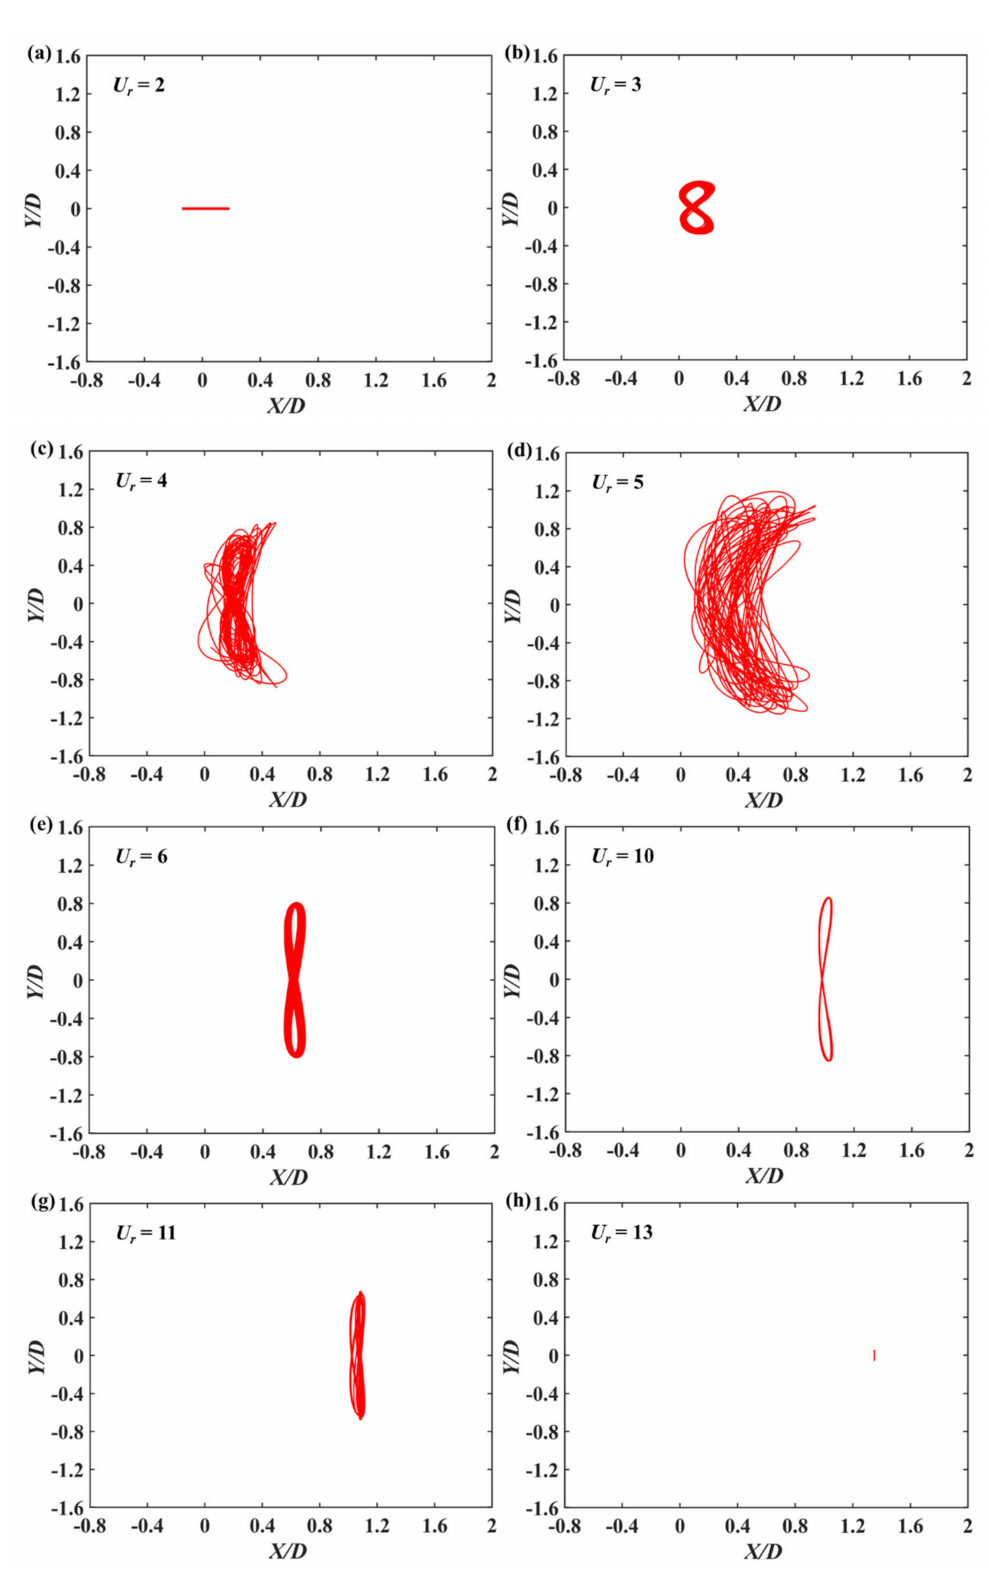
Figure 10. X-Y trajectory of two coupled cylinders at α = 0 ◦ and d/D = 0.05: ( a ) U r = 2; ( b ) U r = 3; ( c ) U r = 4; ( d ) U r = 5; ( e ) U r = 6; ( f ) U r = 10; ( g ) U r = 11; ( h ) U r =